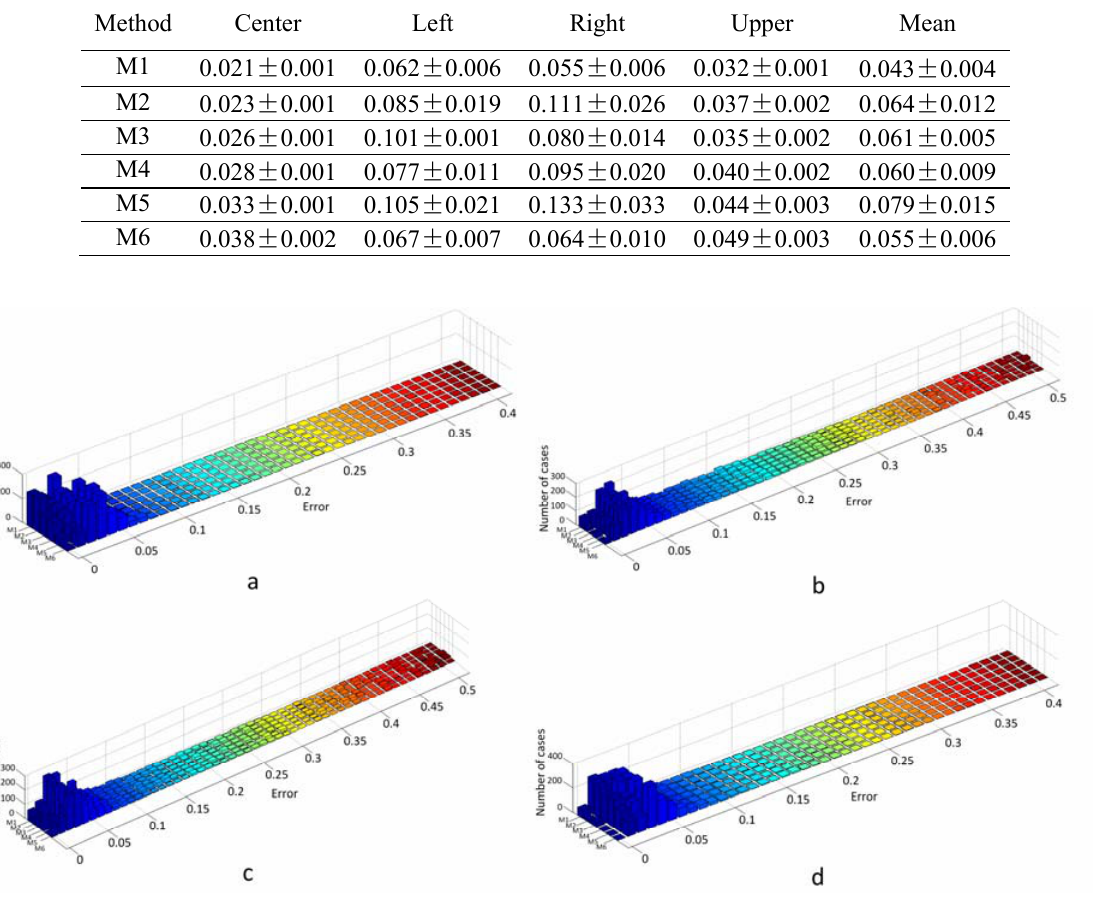
Figure 19: The distribution of error for iris center localization with six methods (M1, M2, M3, M4, M5, and M6). (a) Center, (b) Left, (c) Right, (d)